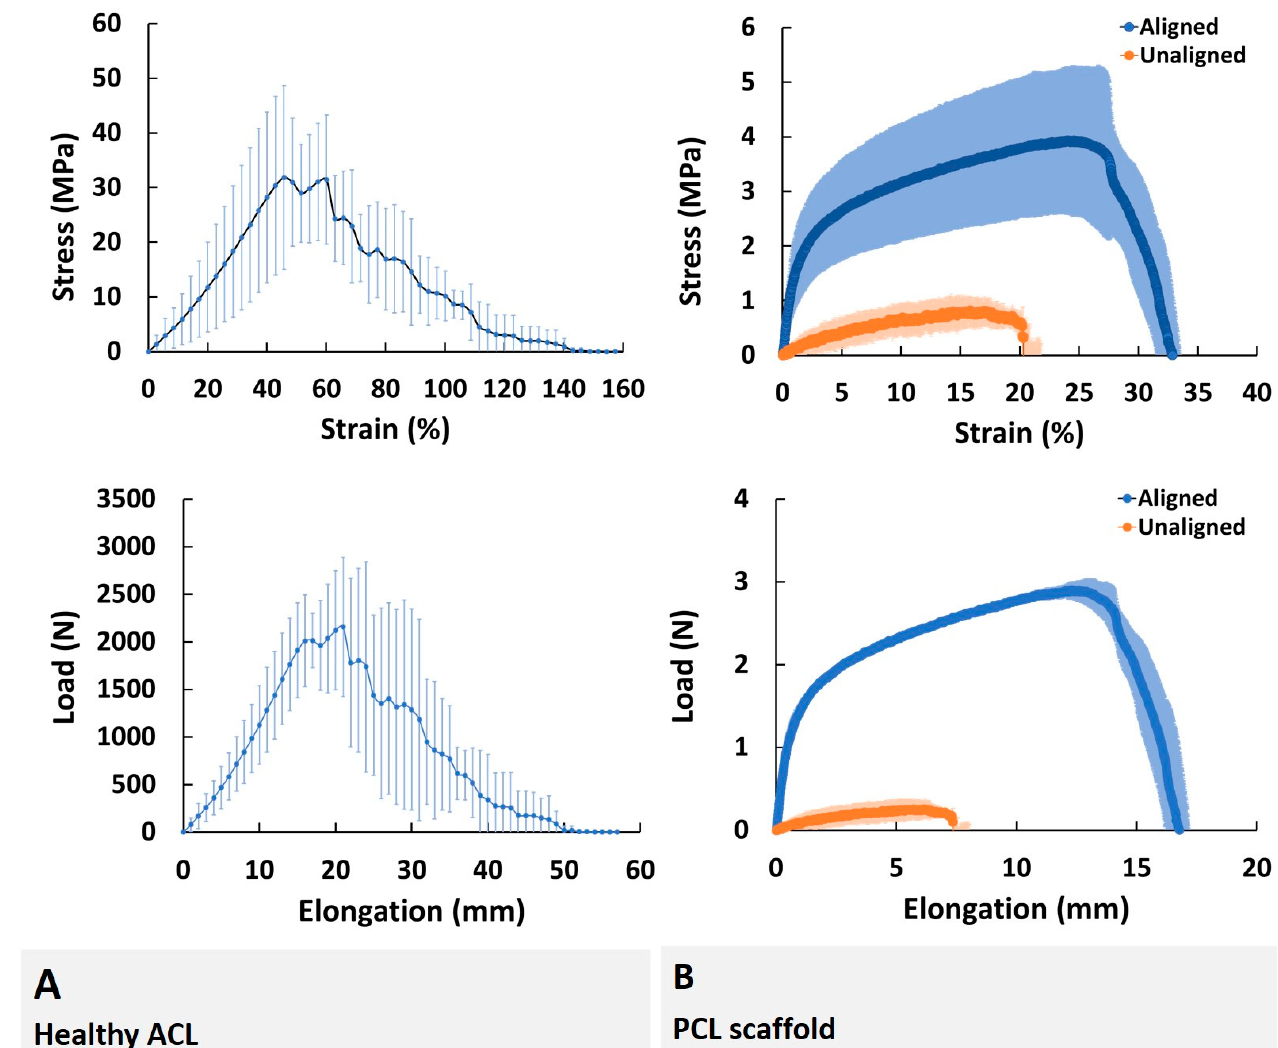
Figure 7. Mechanical properties of native ACL tissue and PCL scaffolds. ( A ) Healthy ACL tissue and ( B ) aligned and unaligned PCL scaffold with bimodal and unimodal fiber diameter distributions, respectively. Error bars represent SD.